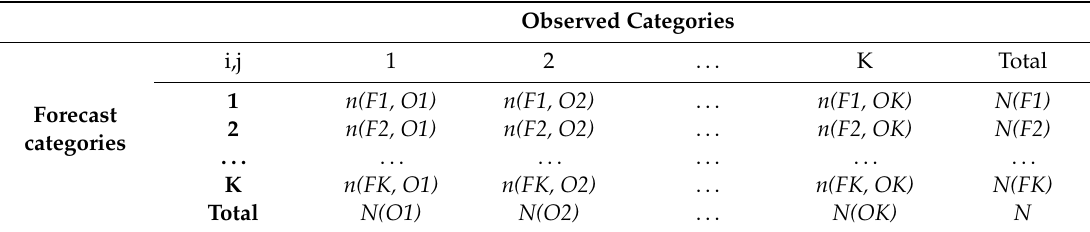
Table 2. Multi-category contingency table [29].